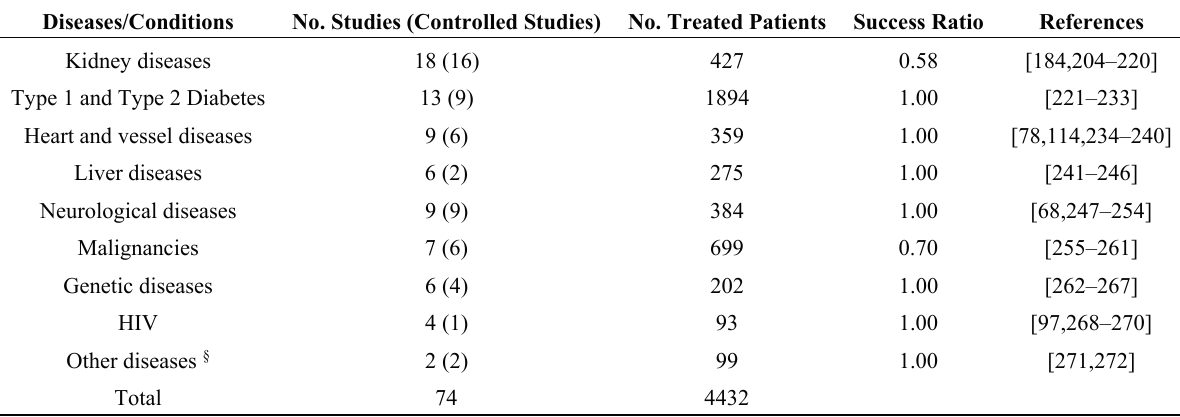
Table 3. Clinical studies utilizing L -carnitine (CARN) (or acetyl-CARN (ALC)) aimed at compensating OS/MDF-related pathogenetic